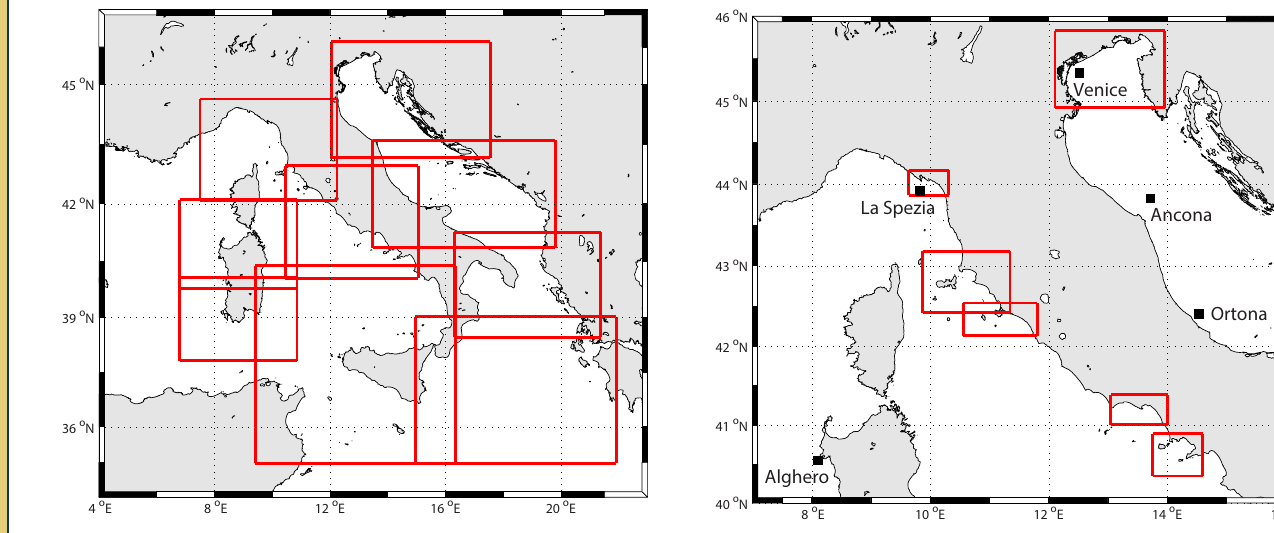
Figure 3. Mc-WAF: implemented coastal